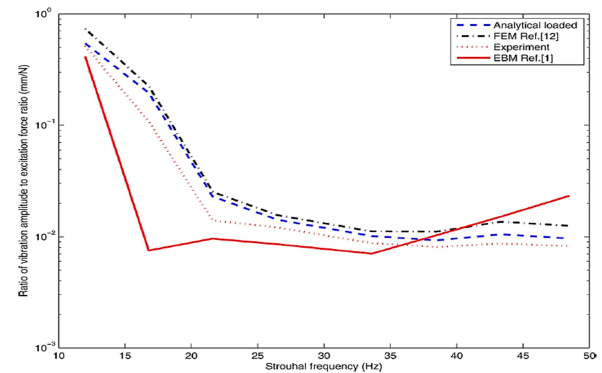
Figure 7: Corroboration for the full conductor ( Ld = ¼ Lc )